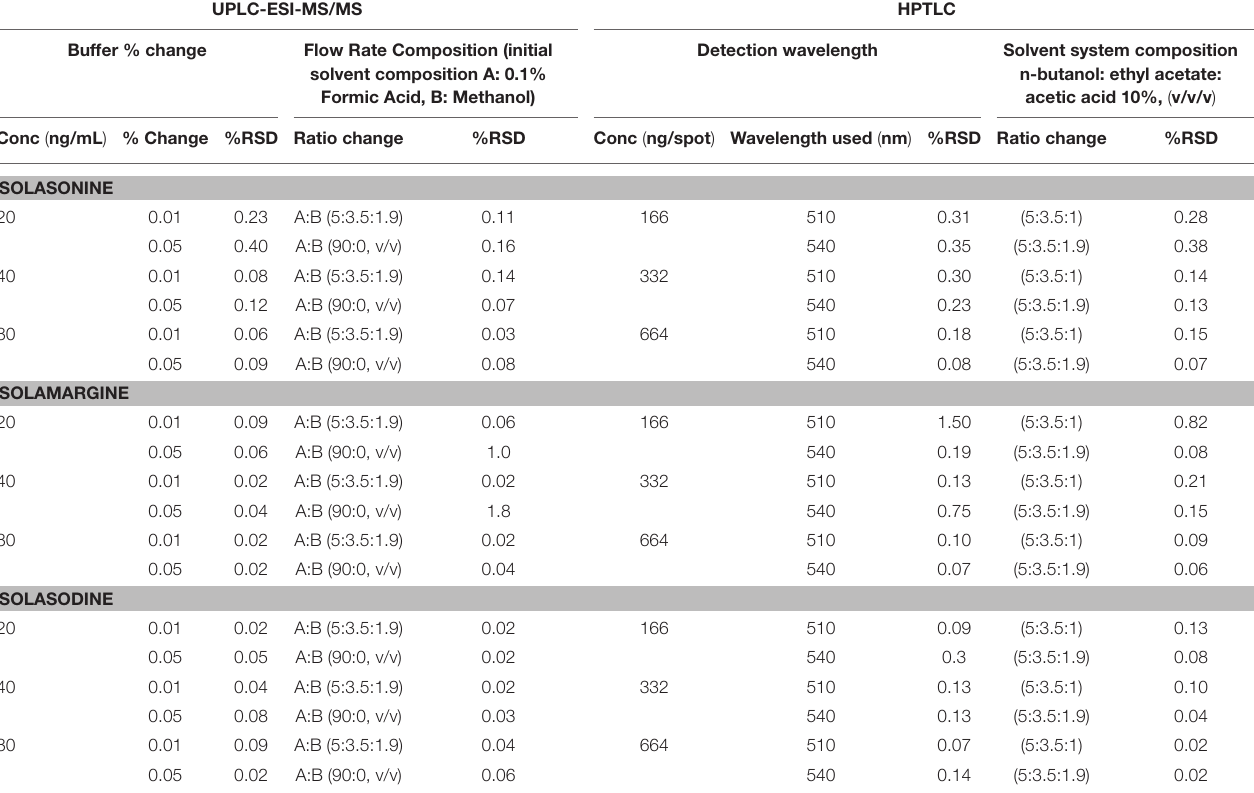
TABLE 6 | Robustness of the UPLC-ESI-MS/MS and HPTLC method for estimation of mixed standards by changing: Buffer % change ( n = 3), Flow rate ( n = 3), detection wavelength ( n = 3), and mobile phase ratio ( n = 3). UPLC-ESI-MS/MS HPTLC Detection wavelength Solvent system composition n-butanol: ethyl